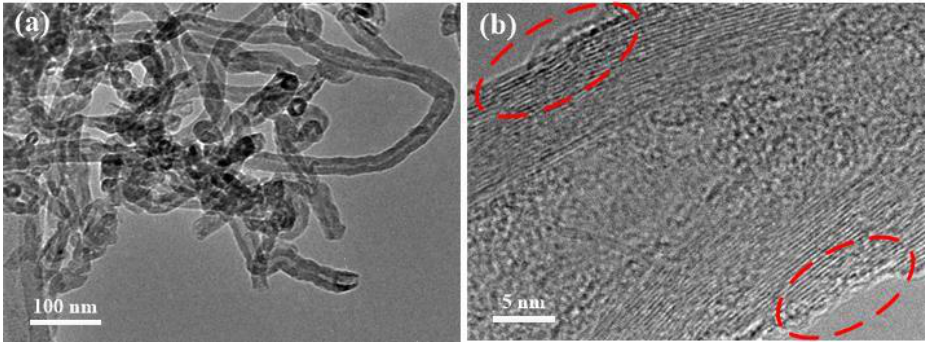
Figure 2. FTIR spectra of MWCNTs, MWCNTs-COOH, MWCNTs-COCl and MWCNTs-APTES.